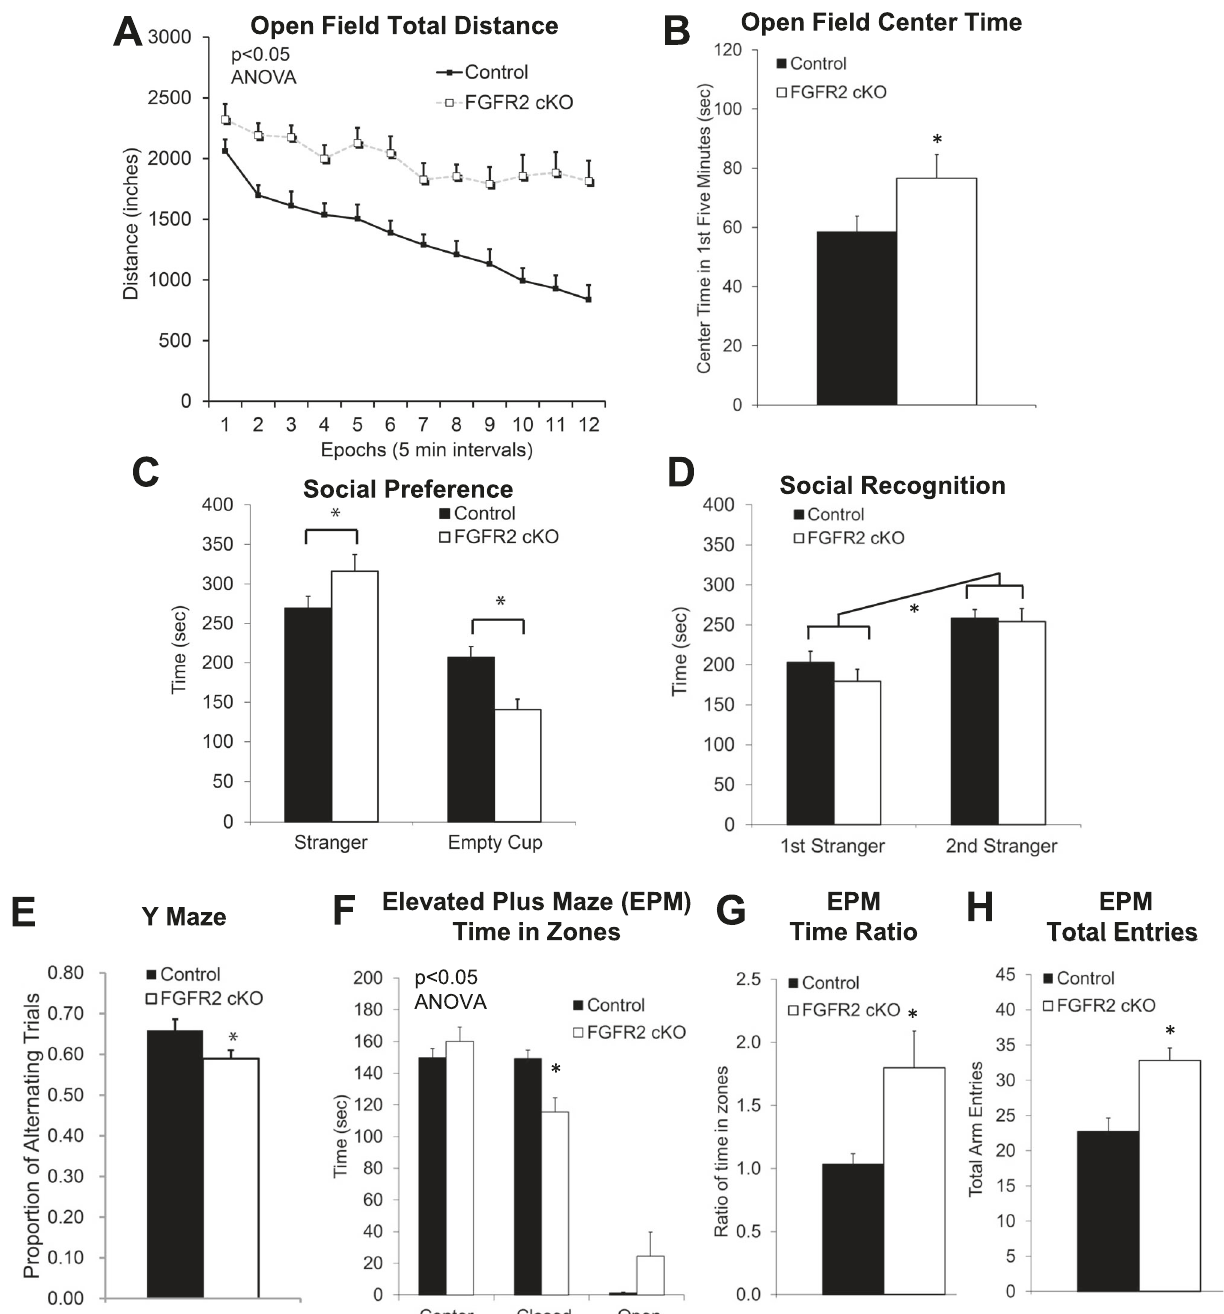
Fig. 1 Adult male mice embryonically lacking FGFR2 driven by hGFAP-Cre (beginning by at least E13.5) showed locomotor hyperactivity, reduced anxiety-like behavior, increased sociability, and reduced working memory. A Persistently increased distance traveled in the open fi eld in FGFR2 cKO mice. B Reduced anxiety-like behavior with open fi eld increased time in the center in FGFR2 cKO mice. C Three chamber social task with social side compared with non-social side showed increased social preference in FGFR2 cKO mice. D Three chamber social task with familiar social side compared with novel social side showed no differences in social recognition. E Reduced working memory with less Y maze spontaneous alternation in FGFR2 cKO mice. F Reduced anxiety-like behavior with altered time spent in the closed and open arms of the EPM. G Reduced anxiety-like behavior with altered ratio of time in zones of the EPM. H Increase locomotor activity with increased overall entries into all arms of the EPM. N = 14,14; * p < 0.05 two-tailed Student ’ s t -tests or ANOVA. Means and SEM similar to that previously characterized in FGFR1 cKO mice (Fig. 1A; 55% greater; rmANOVA: F(1,26) = 20.17, p = 0.0001) [12]. Com- pared to their control littermates, FGFR2 cKO mice were more active in an open fi eld, also spending more time in the center of the open fi eld (Fig. 1B; p = 0.04)), a phenotype suggesting reduced anxiety-like behavior.